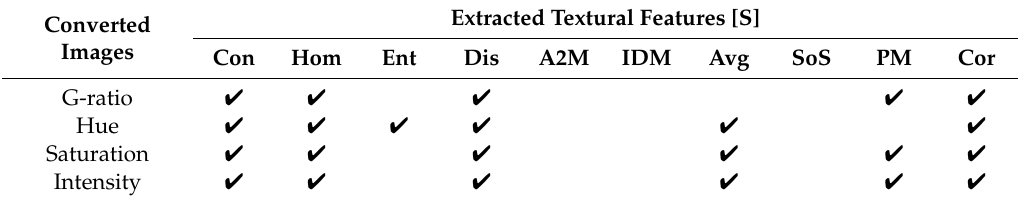
Table 3. Selected textural